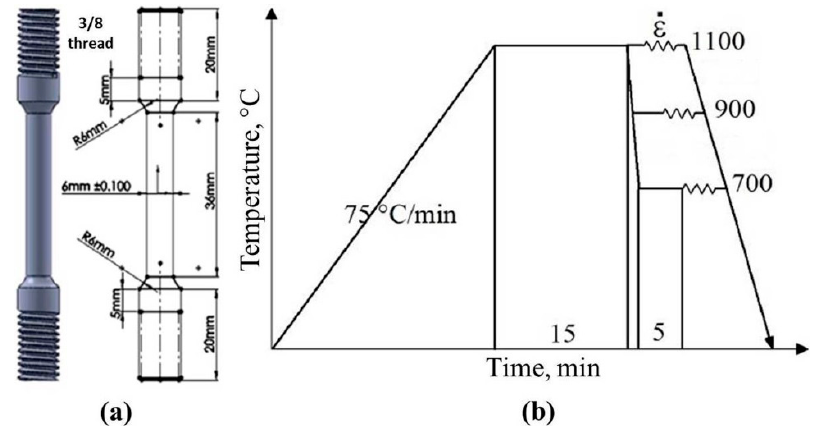
Figure 2. Hot tensile testing: ( a ) cylindrical sample and ( b ) applied thermal cycle.